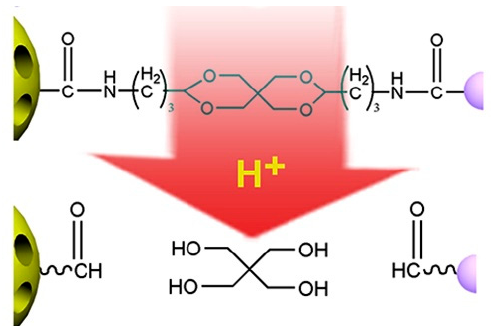
Figure 5. Schematic illustration of the envelope-type mesoporous silica nanoparticle for pH-responsive drug delivery. Reproduced with permission from Yan Chen, Kelong Ai, Jianhua Liu, Guoying Sun, Qi Yin, and Lehui Lu, Biomaterials; published by Elsevier,